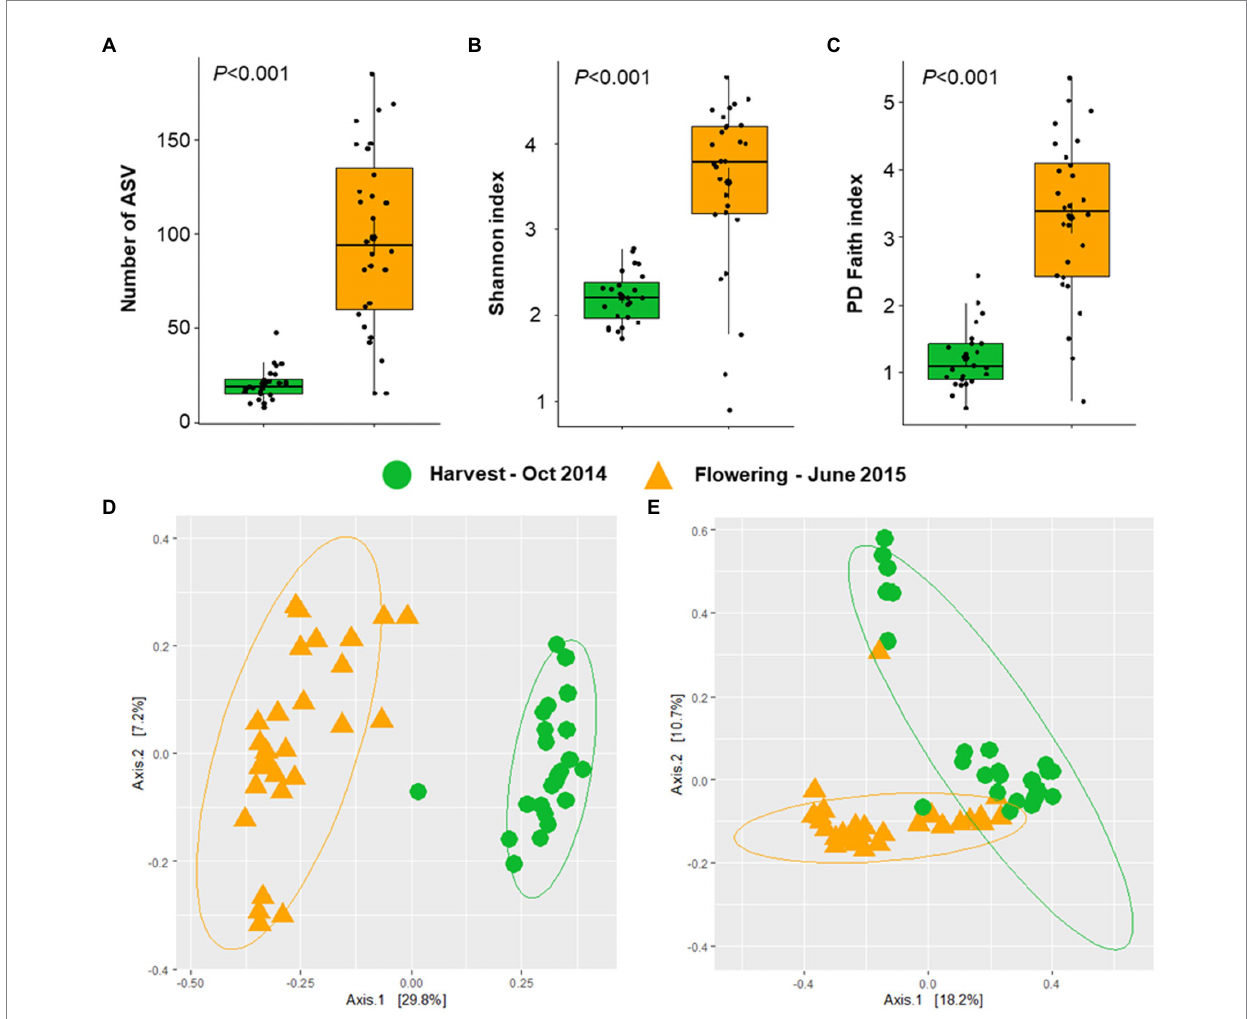
FIGURE 2 Alphaproteobacterial diversity and community structure at two phenological growth stages. Alphaproteobacterial richness and diversity were estimated based on the number of ASVs (A) , Shannon index (B) , and PD Faith index (C) . Significances in alphaproteobacterial diversity (A–C) were determined with the Kruskal Wallis test, representing p < 0.05. Alphaproteobacterial community clustering was assessed based on Bray–Curtis (D) and weighted UniFrac (E) matrix distances and visualized PCoA